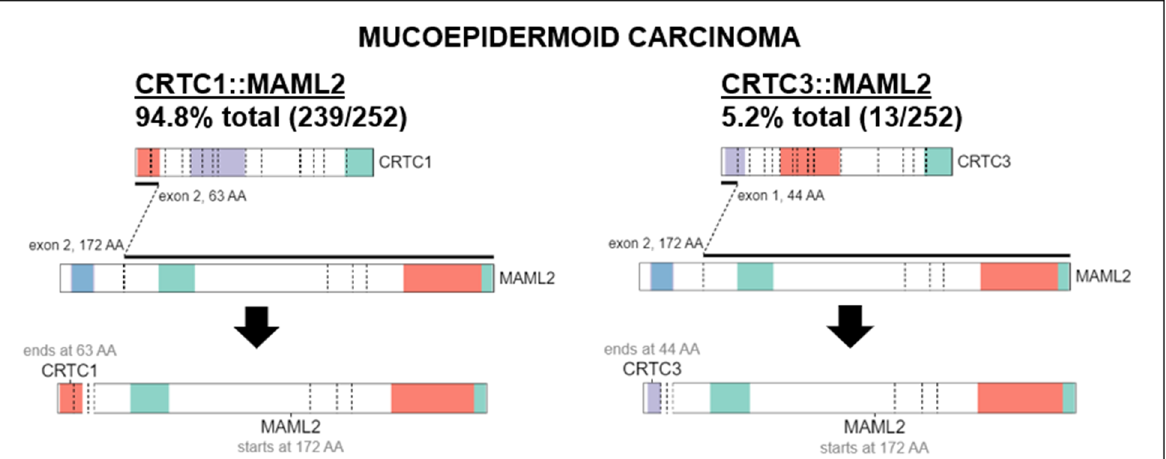
Figure 6. Characteristic fusions identified in MEC. MAML2 fusion to CRTC1 ( Left ) was found in 94.8% of all cancers histologically classified as MEC while MAML2 fusion to CRTC3 ( Right ) was found in the remaining 5.2%. Fusion data were visualized using ProteinPaint software (https://pe- can.stjude.cloud/proteinpaint, accessed on 15 October